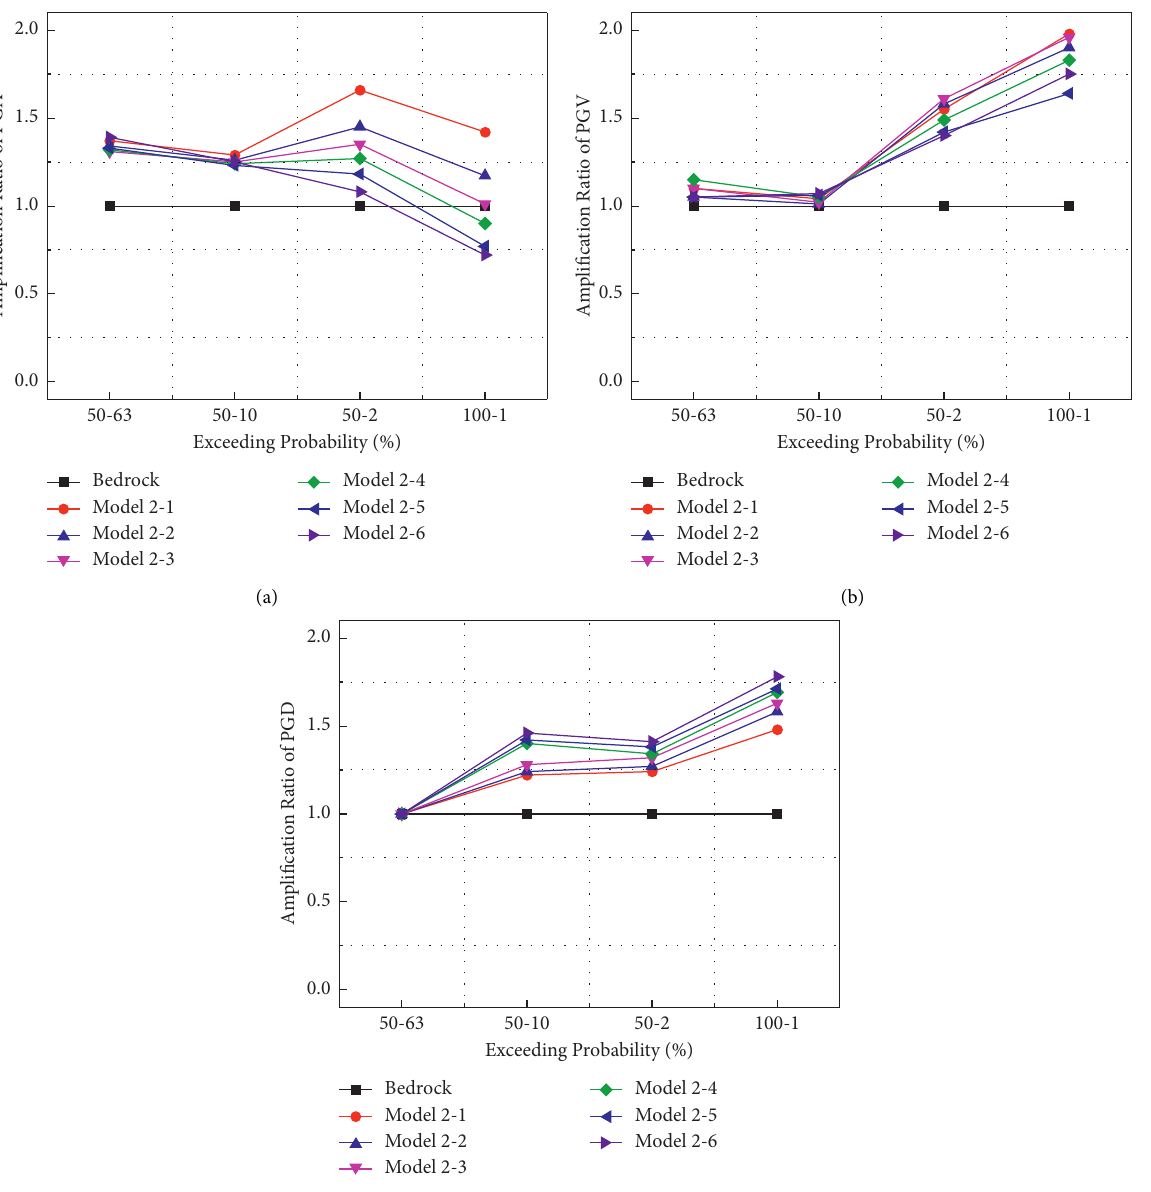
Figure 5: Amplification ratios of ground motion for the six multiple interbedded models under four seismic